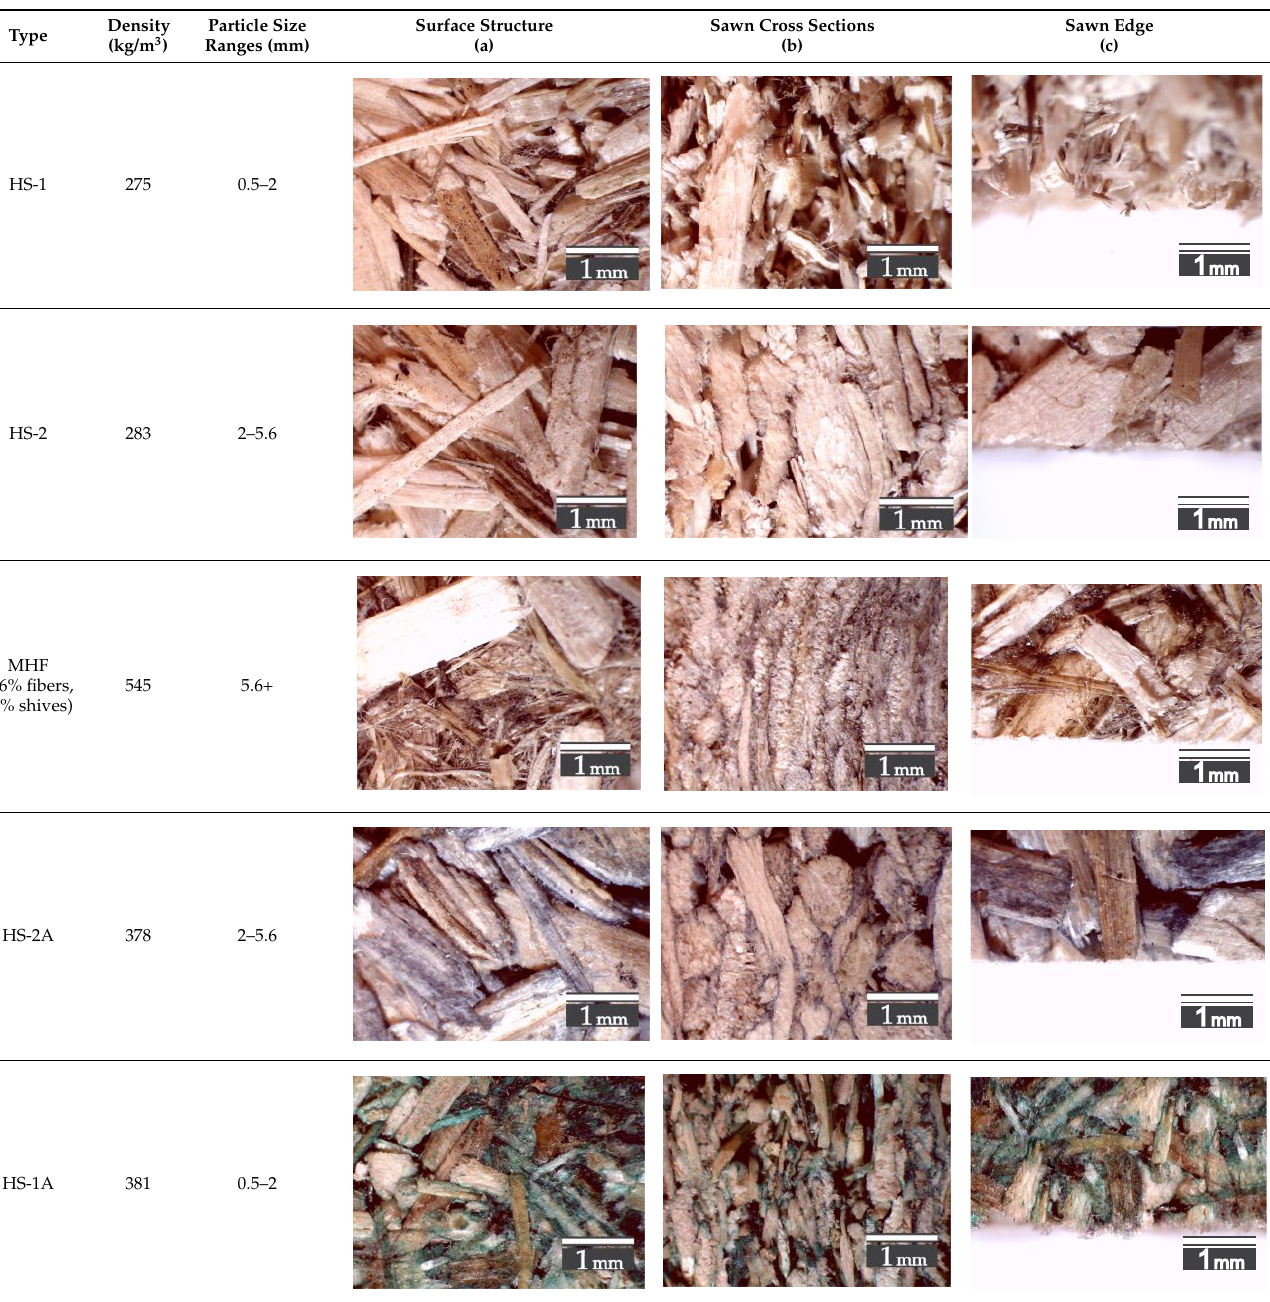
Table 3. Material structure analysis at 15 ×